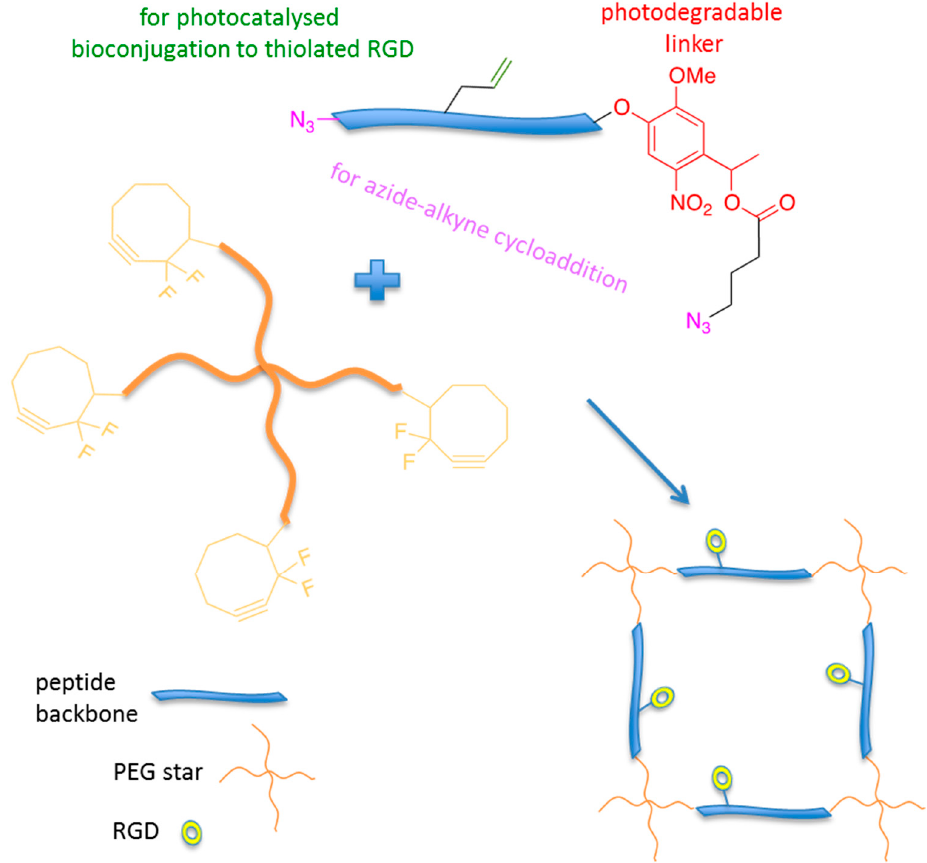
Figure 4. Strategy for the synthesis of photodegradable adhesive hydrogels for advanced 3D cell culture.